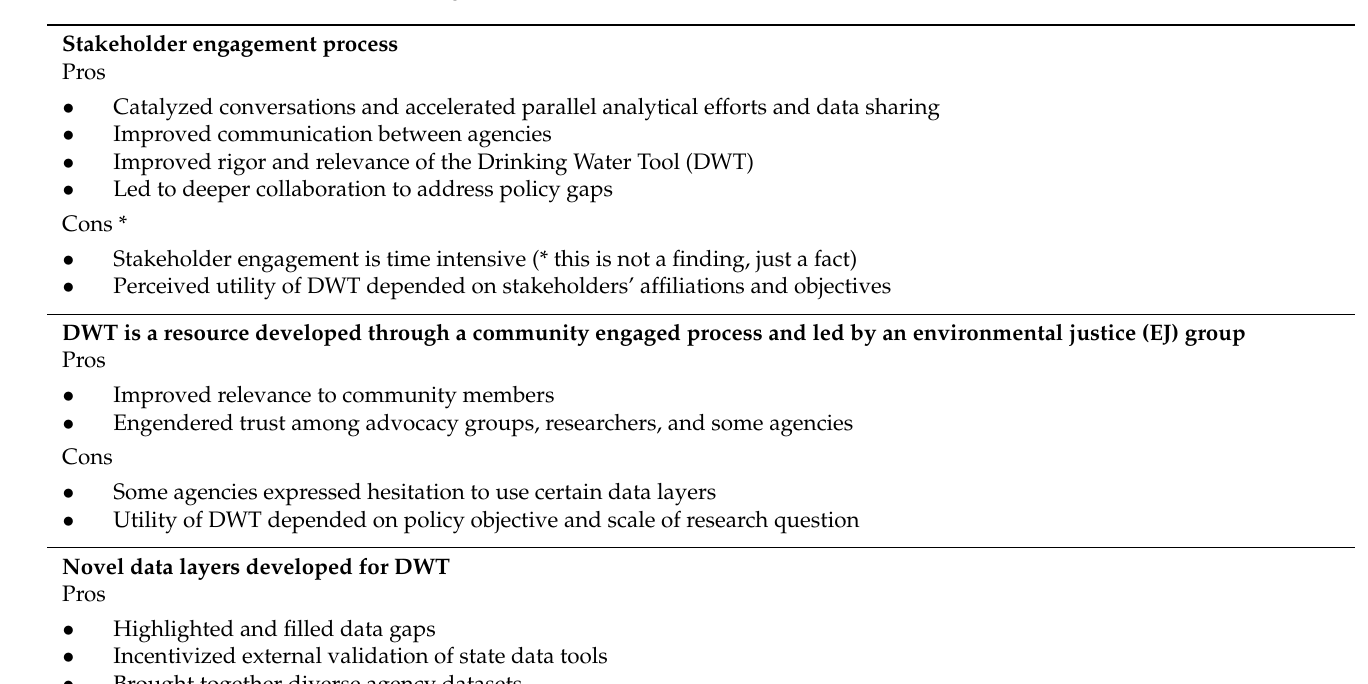
Table 1. Summary of main findings: pros and cons of the DWT development process and resulting